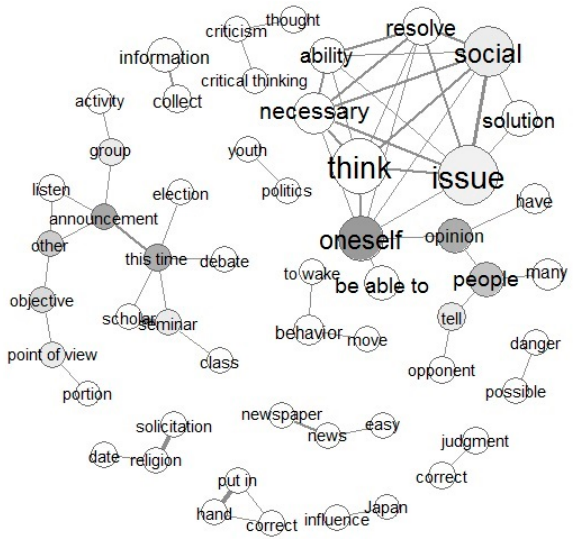
Figure 1. Co-occurrence words network of Task 1 responses to “What kind of skills and attitudes do you think are necessary to resolve any kind of social issue?”.